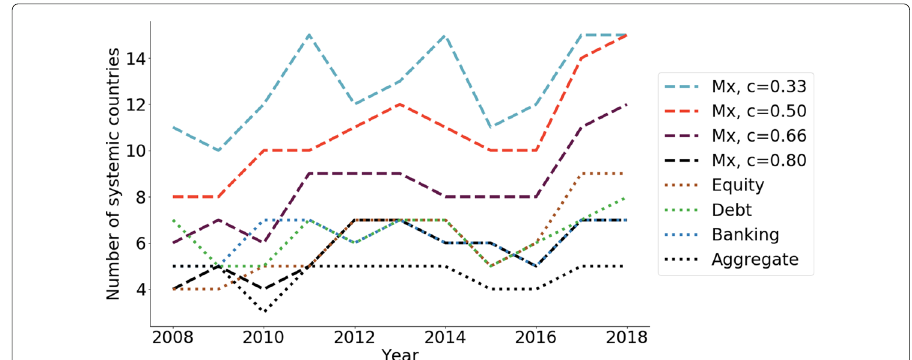
Fig. 5 The number of systemically important countries (which we abbreviate as “systemic countries” in the axis label) over time in the multiplex global financial network and in its associated monolayer networks. We show simulations on the multiplex global financial network (which we abbreviate by “Mx” in the legend) using dashed curves and simulations on the monolayer networks using dotted curves. For the multiplex network, blue, reddish orange, purple, and black curves correspond to vertical thresholds of 0.33, 0.50, 0.66, and 0.80, respectively. For the monolayer networks, brown, green, blue, and black curves correspond to the equity, debt, banking, and aggregate networks,